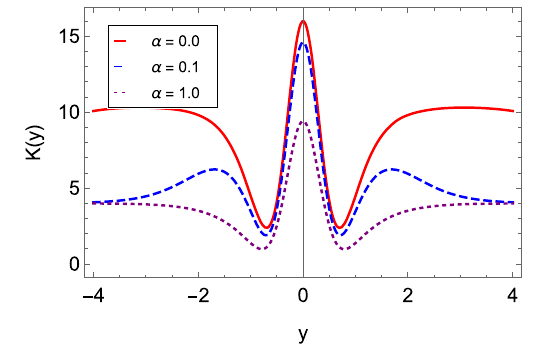
Fig. 6 Numerical solutions for the Kretschmann scalar K ( y ) from Eq. (46) with φ 0 = k = 1 for different values of α